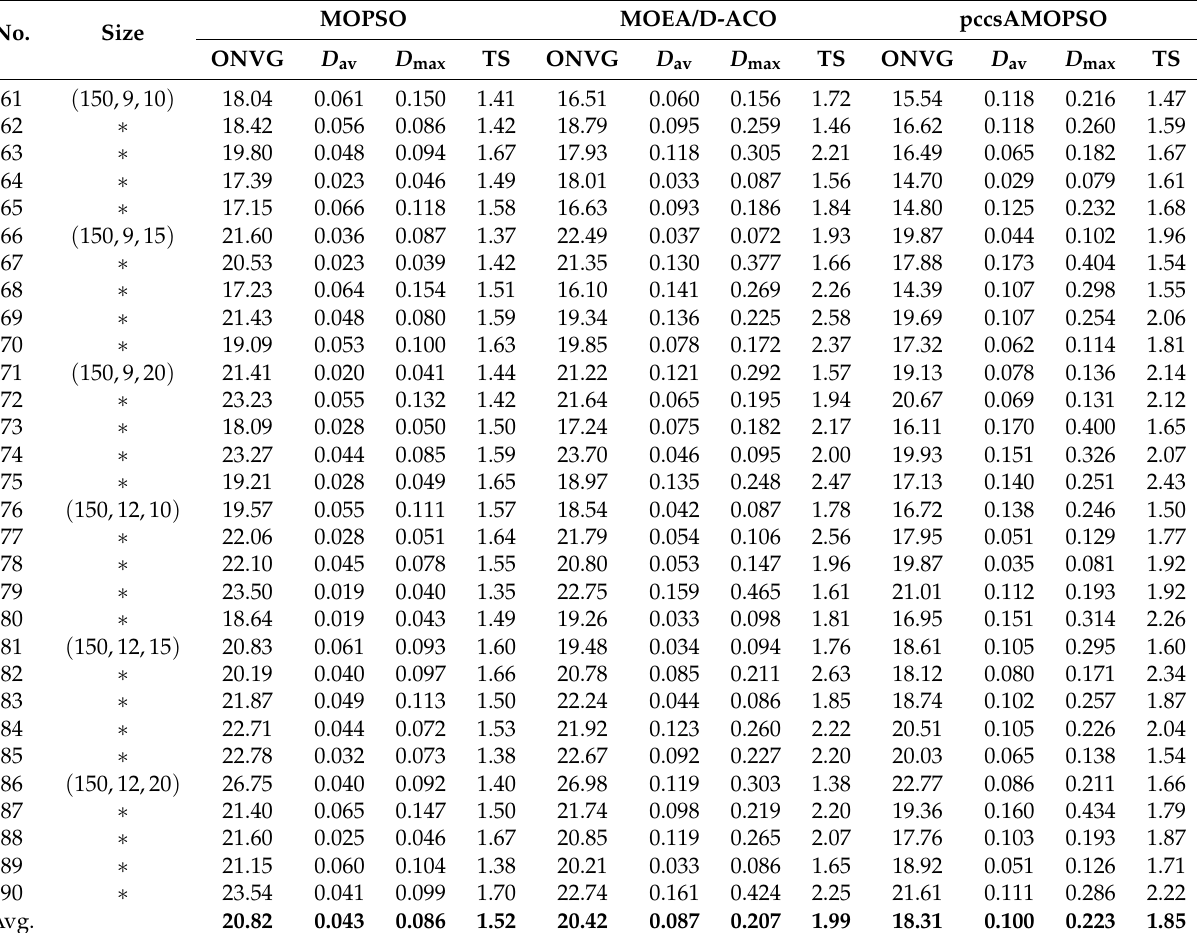
Table 6. Comparison of MOPSO with MOEA/D-ACO and pccsAMOPSO on the test instances with 150